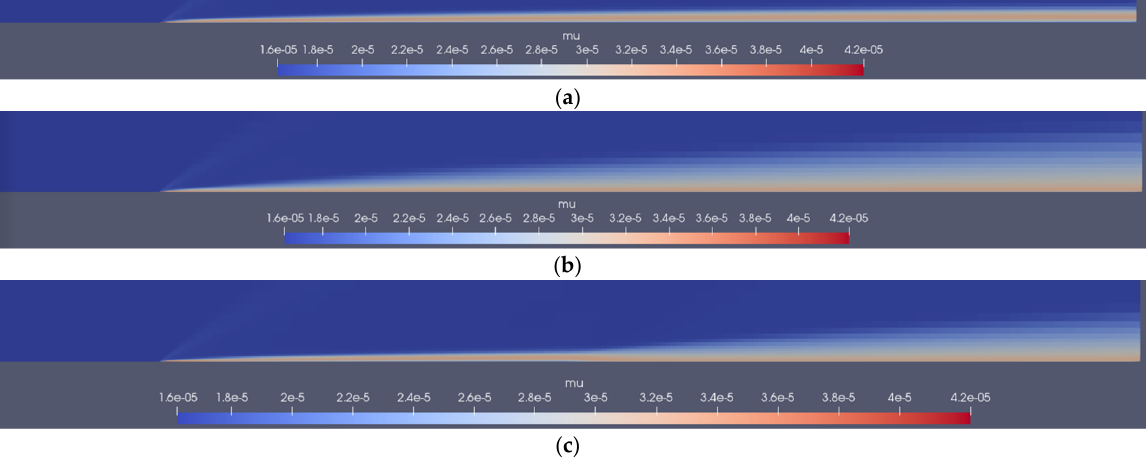
Figure A4. Dynamic viscosity profile of s00: ( a ) laminar model; ( b ) SA model; ( c ) SA-BCM model.